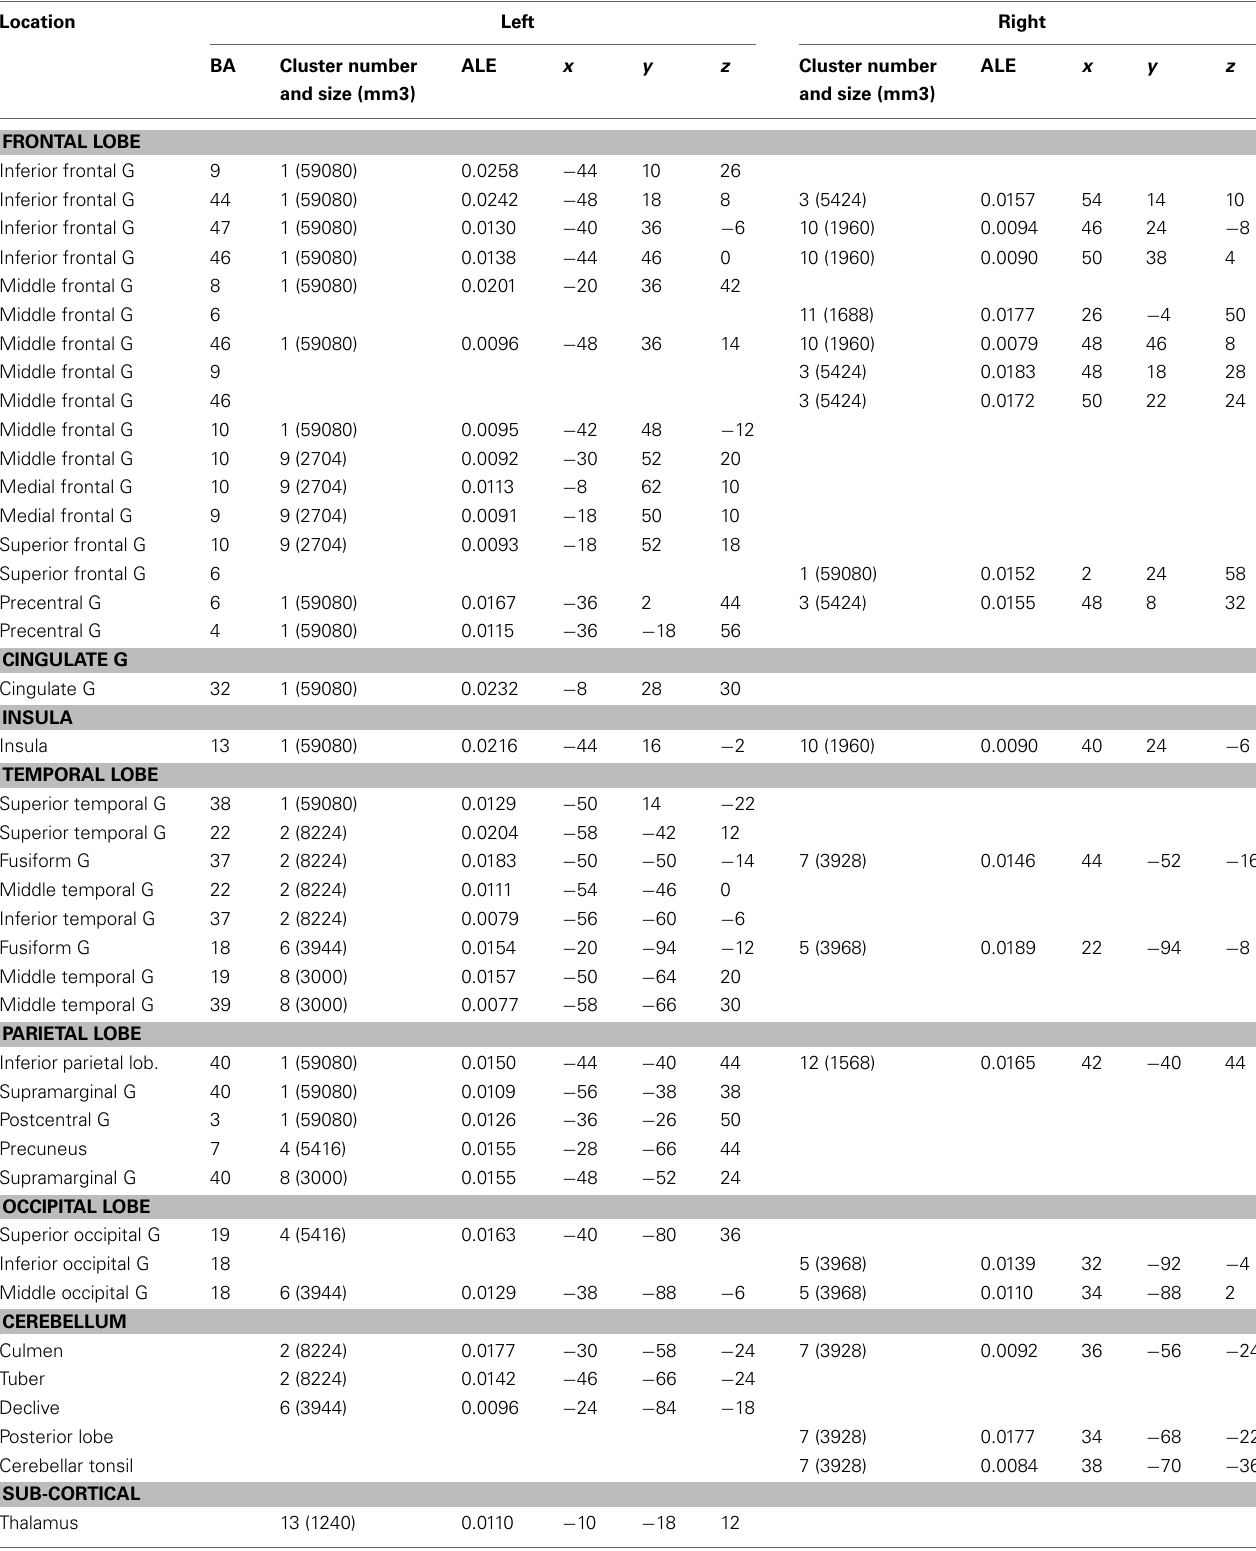
Columns number 3–7 represent data associated with the left hemisphere and 7–12 represent data associated with the right hemisphere. Abbreviations: BA, approximate Brodmann area; ALE, activation likelihood estimation; G, gyrus; Lob, lobule; x, y, z coordinates, peak voxel in the Montreal Neurologic Institute (MNI)